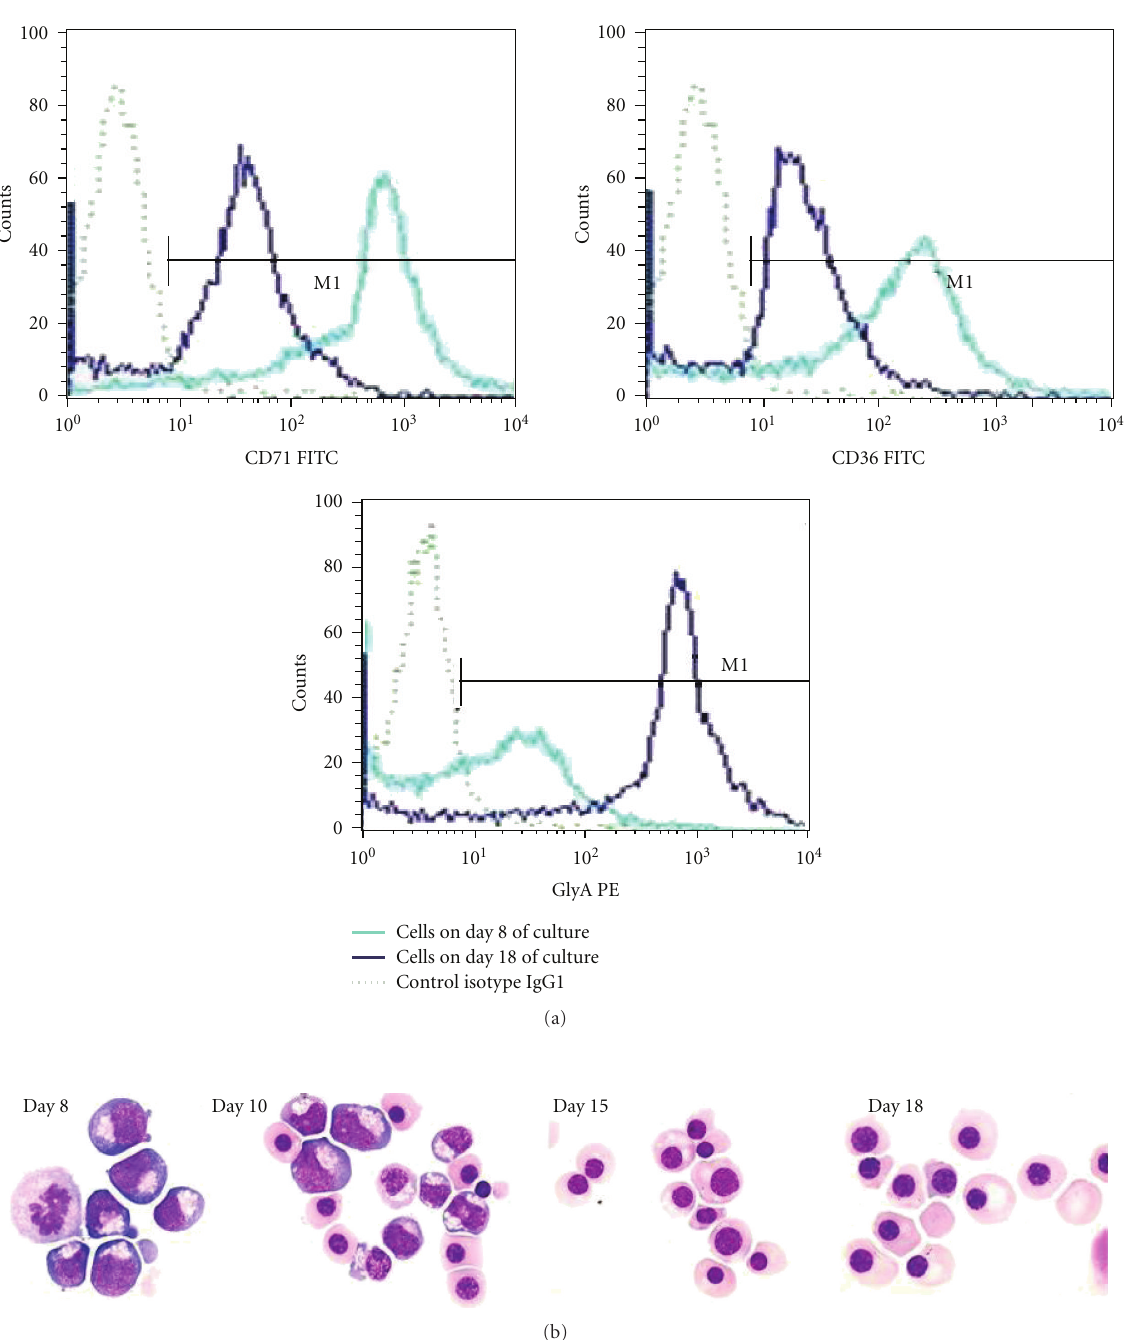
Figure 3: Maturation of FL-derived erythroid cells. (a) FACS analyses of transferrin receptor (CD71), CD36 and glycophorin A (CD235a) expression on days 8 and 18 of liquid culture. Data are from one representative experiment and the green, light blue and dark blue, tracings represent the negative control and cells from days 8 and 18 of culture, respectively. (b) Photographs of the cells on days 8, 10, 15, and 18 of liquid culture after May-Gr¨unwald-Giemsa staining. Every stage of erythroid maturation is represented: proerythroblast, basophilic erythroblast, polychromatophilic erythroblast, orthochromatic erythroblast, and RBCs (magnification × 50).